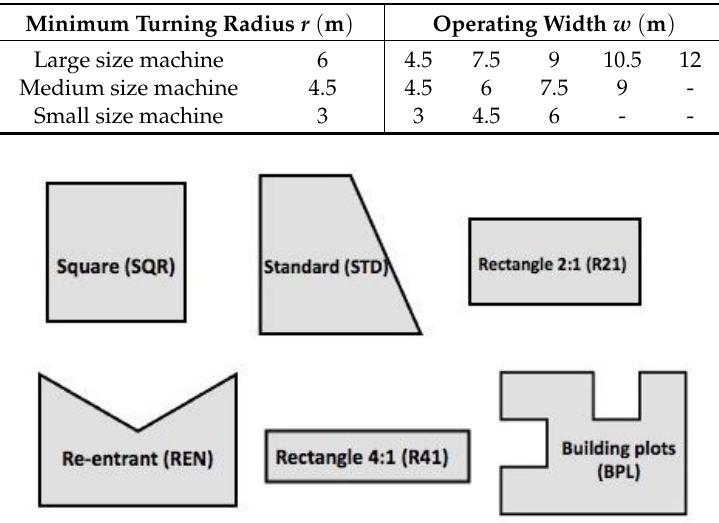
Figure 8. The six template fields that were selected as test fields.